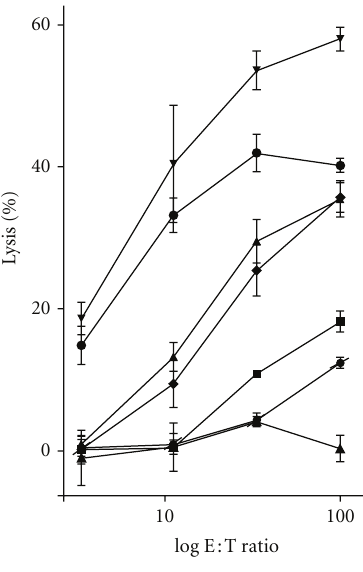
Figure 5: Elispot assay showing a relationship between adjuvant activity of glycosylarchaeol/PGP archaeosomes, archaetidylserine (AS), and archaetidylethanolamine (AE). Mol% compositions for OVA-archaeosome vaccines were mannotriosyl-A/gentiotriosyl- A/PGP (22.5/22.5/55), mannotriosyl-A/gentiotriosyl-A/AS/PGP (22.5/ 22.5/30/25), mannotriosyl-A/gentiotriosyl-A/AE/PGP (22.5/ 22.5/5/50), mannotriosyl-A/gentiotriosyl-A/AS/AE/PGP (22.5/ 22.5/30/5/20). Assays were conducted on splenic cells of mice 6 weeks post first immunization.